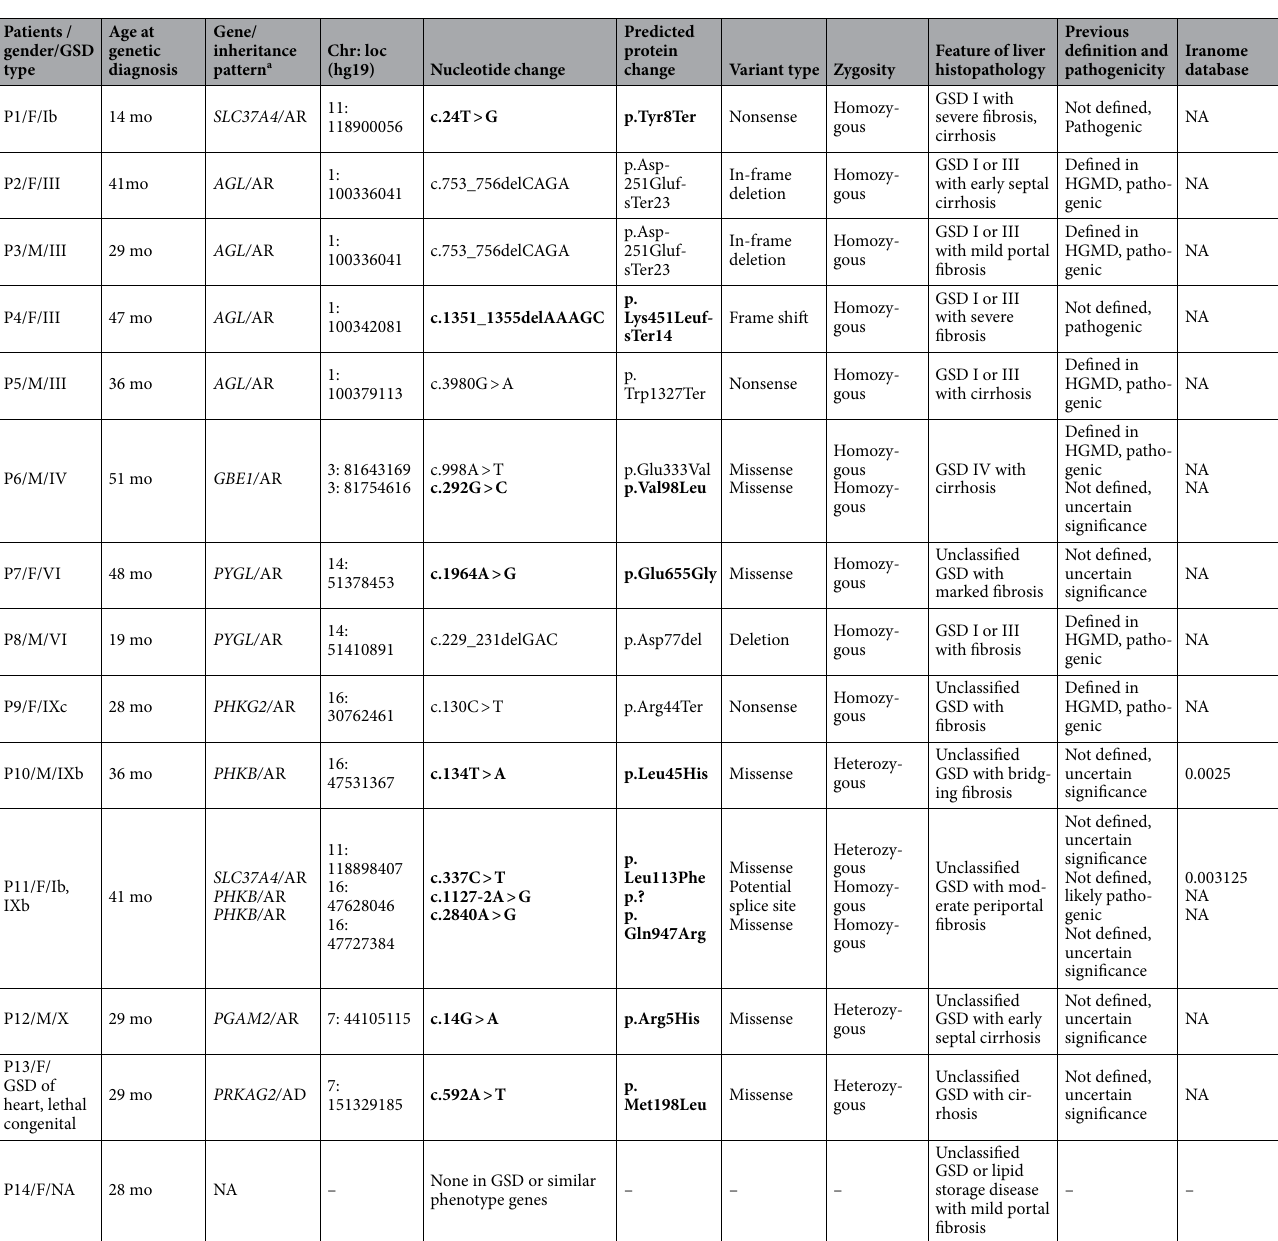
Table 2. Summary of GSD mutations detected by MPS-GSD panel. Bold type represents novel unclassified variants. AD autosomal dominant, AR autosomal recessive, Chr Loc chromosome location, F female,